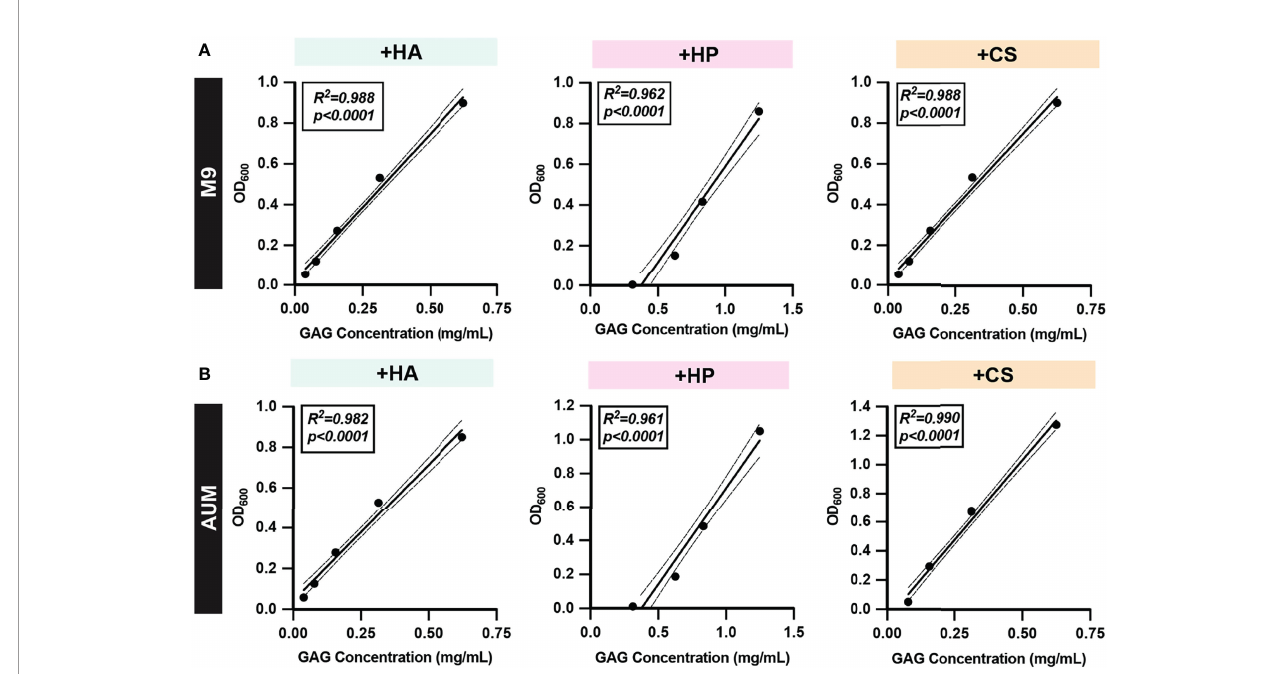
FIGURE 3 | Representative GAG standard curves. Two-fold serial dilutions of (A) M9 and (B) AUM media with HA, HP, and CS were prepared and the GAG degradation assay protocol was performed to obtain post-acetic acid OD 600 . Simple linear regressions were performed and R-squared (R 2 ) and p -values are shown. All dots represent the mean across three biological replicates. Solid lines represent line-of-best- fi t and dotted lines represent 95% con fi dence intervals. Values within the linear dynamic range and con fi dence interval of experimentally generated standard curves were used to calculate semi-quantitative GAG concentrations and interpolate GAG concentrations